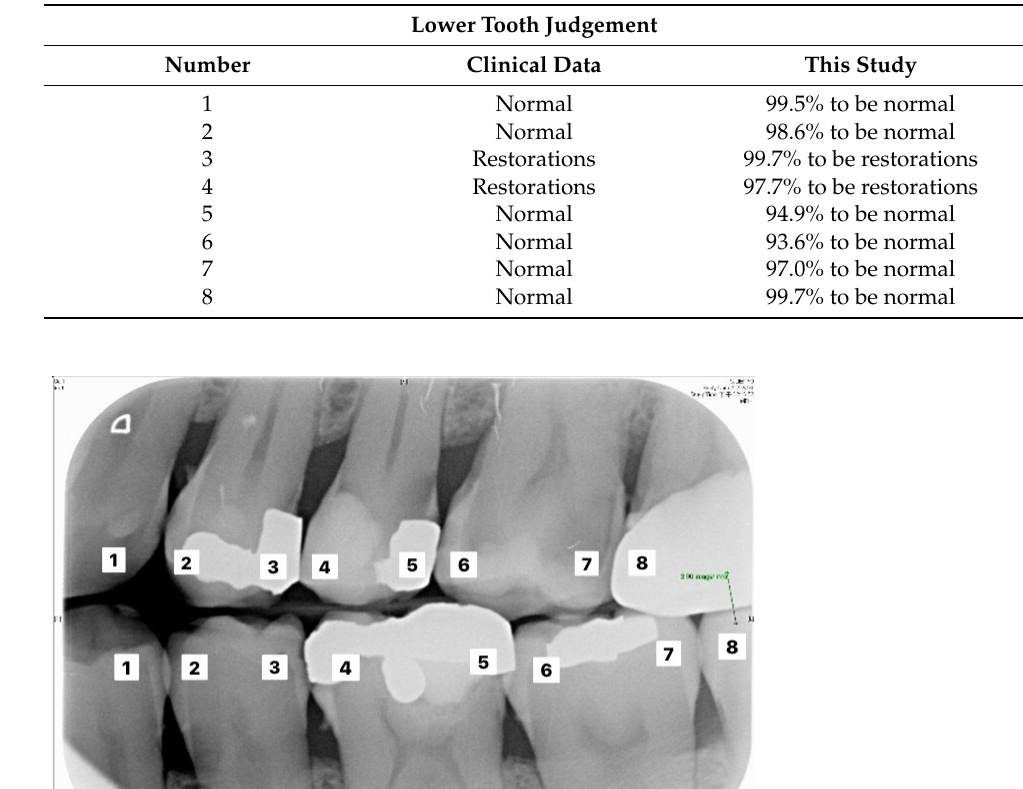
Table 7. Lower tooth judgement for the image in Figure 10.